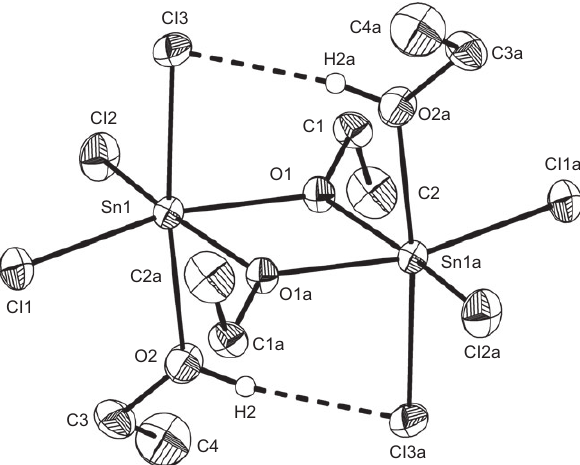
Table 1 Crystal data and structure refinement of Sn